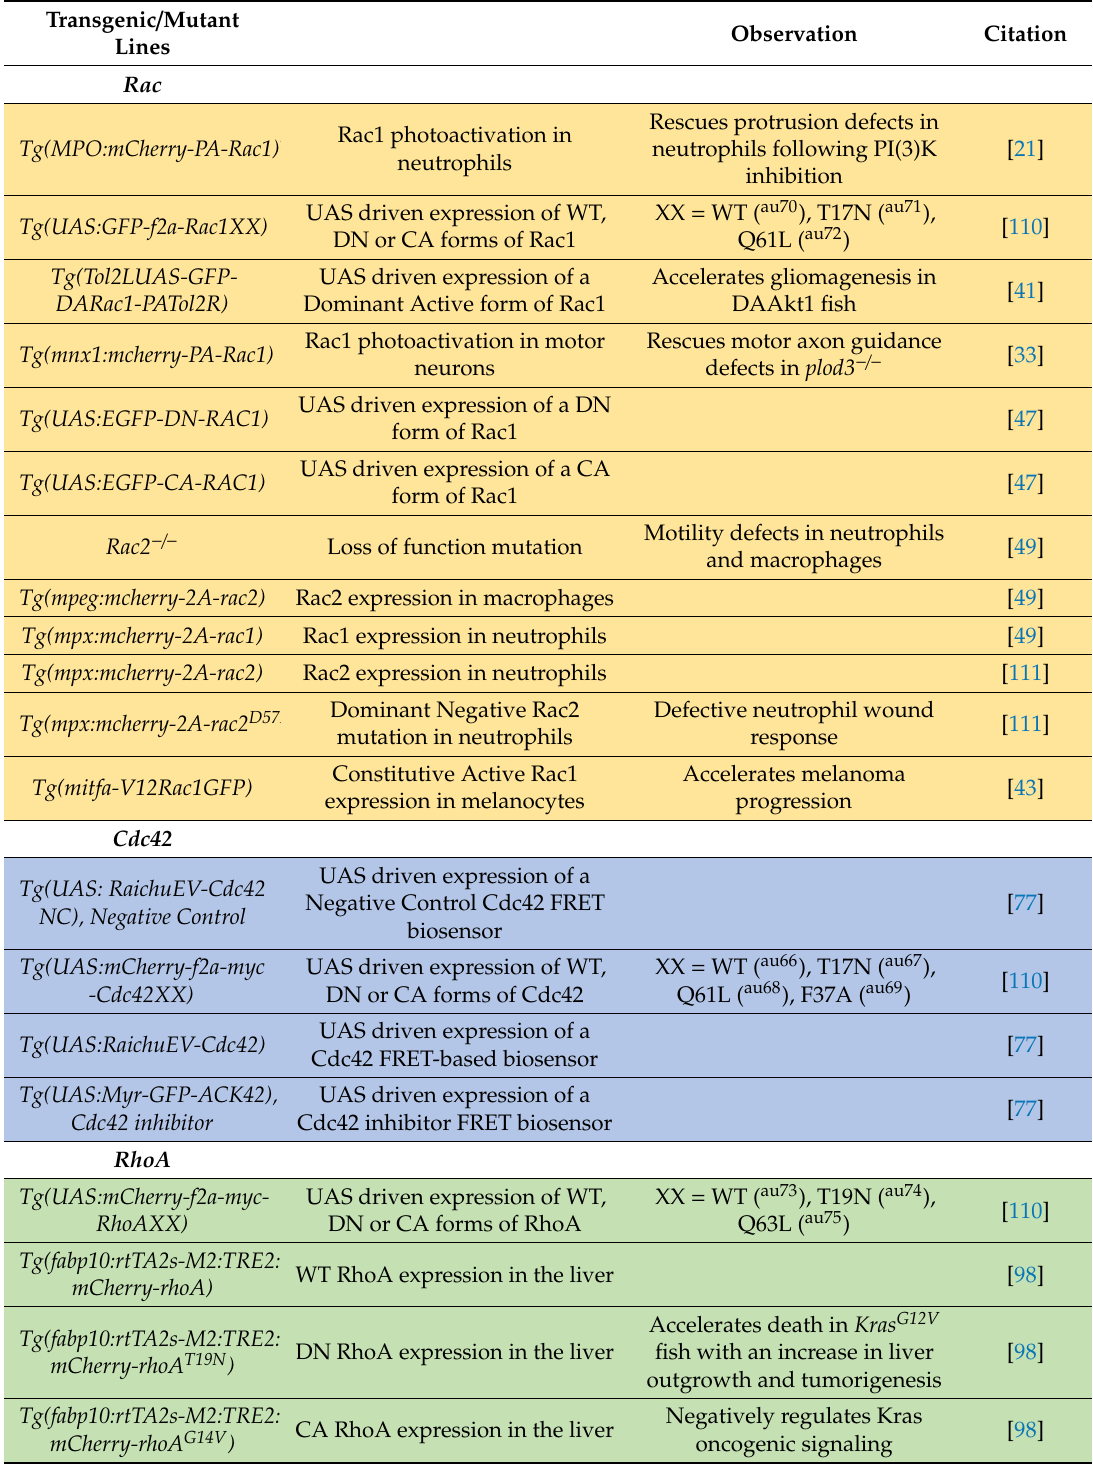
Table 1. Available transgenic lines to study Rho GTPases in